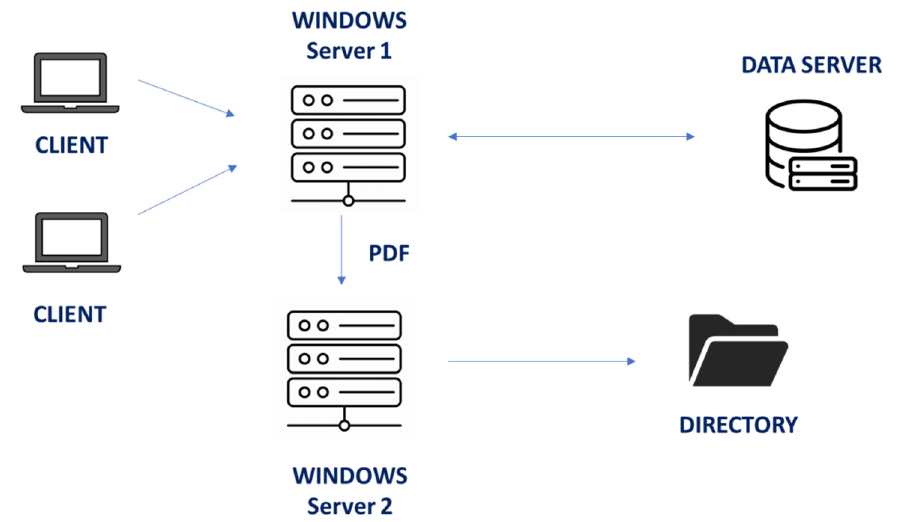
Figure 11. Architecture of the CEHRS emergency system.